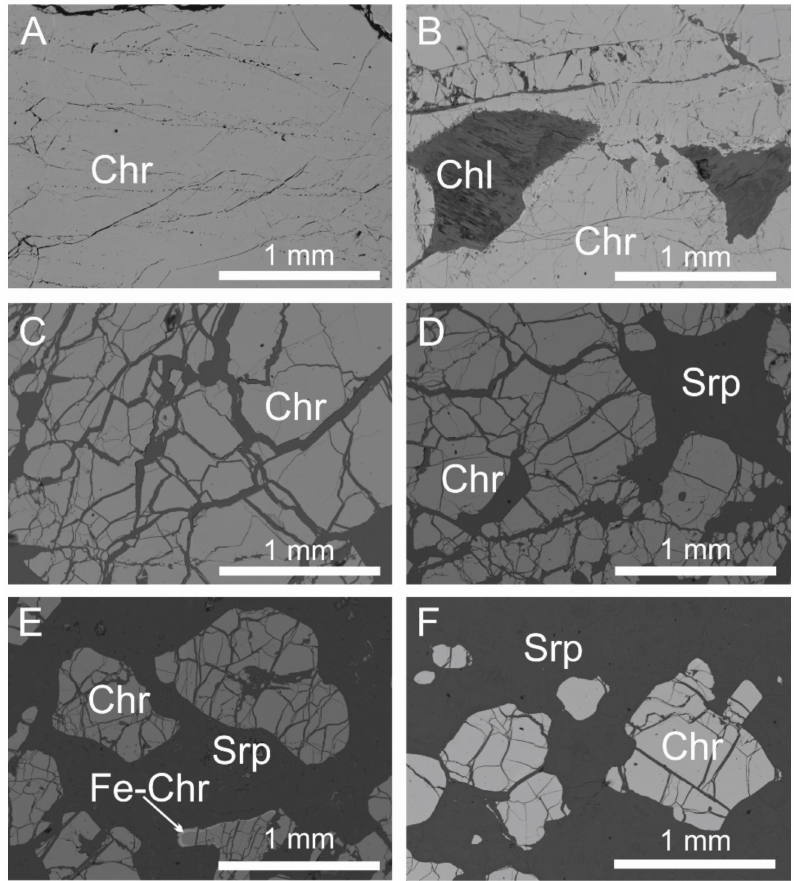
Figure 4. Back-scattered electron (BSE) images of polished sections from the Sebuku chromitites, showing massive ( A ) and partially brecciated chromite ( B ), fractured chromite ( C , D ) and massive chromite with about 40% of altered silicates ( E , F ). Few chromite grains show a thin rim of ferrian chromite ( E ). The altered silicates consist of serpentine and chlorite. Abbreviations: Chr—chromite, Chl—chlorite, Srp—serpentine, Fe-Chr—ferrian chromite.